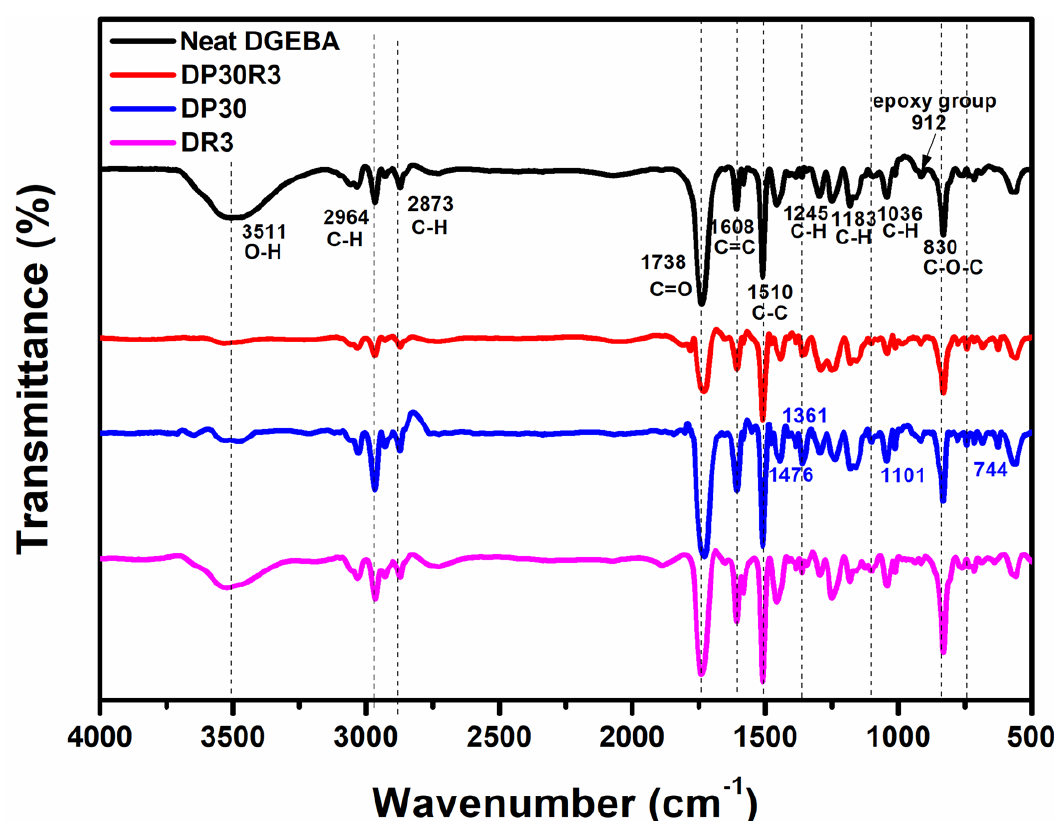
Figure 5. The FT − IR spectra of DR3, DP30, DP30R3, and neat DGEBA.